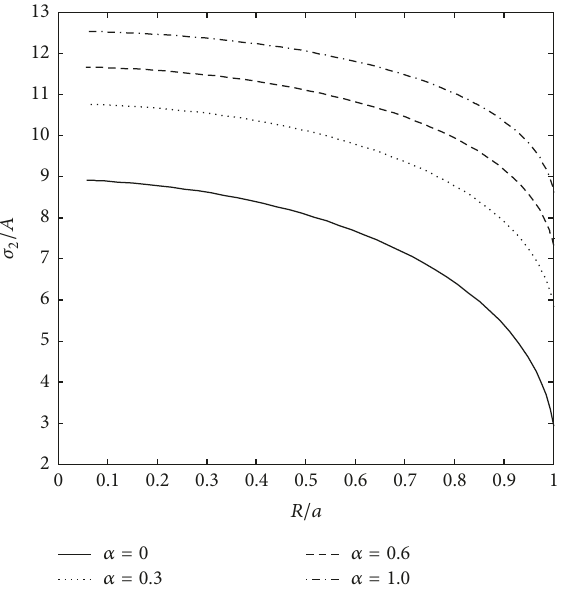
Figure 12: The circumferential stress distribution on membrane ( 𝑞/𝐴 = 10 ; 𝑛 = 2